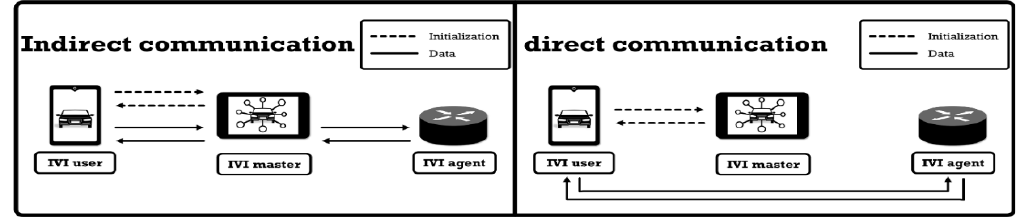
Figure 7. Indirect and direct communications .